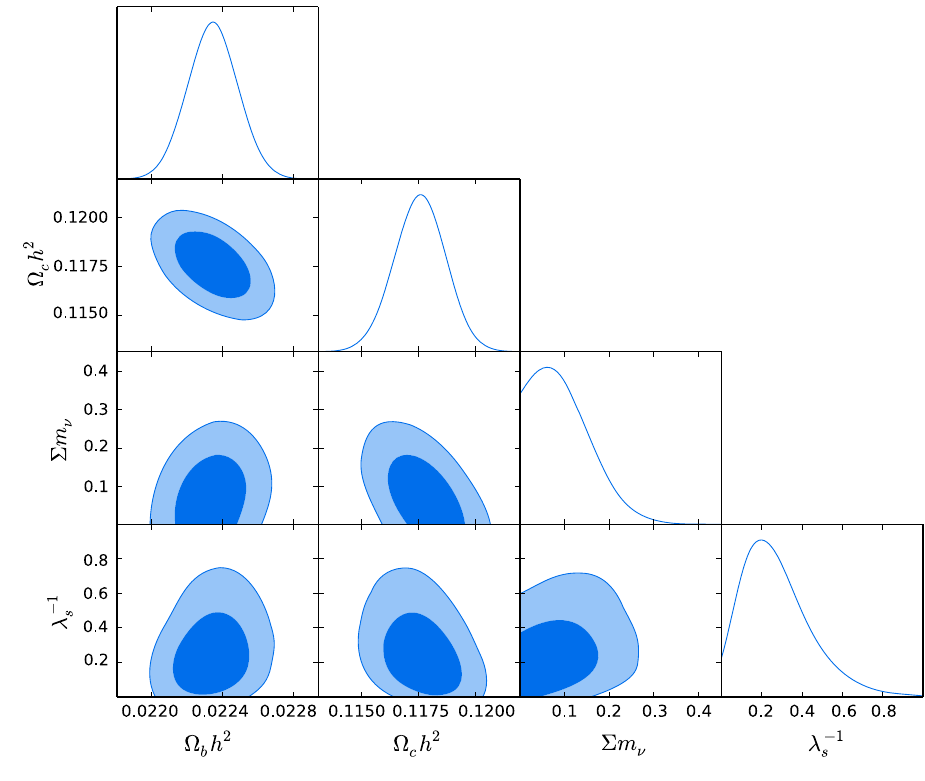
Fig. 4 Legend is the same as Fig. 3 but in the Starobinsky gravity model with n =